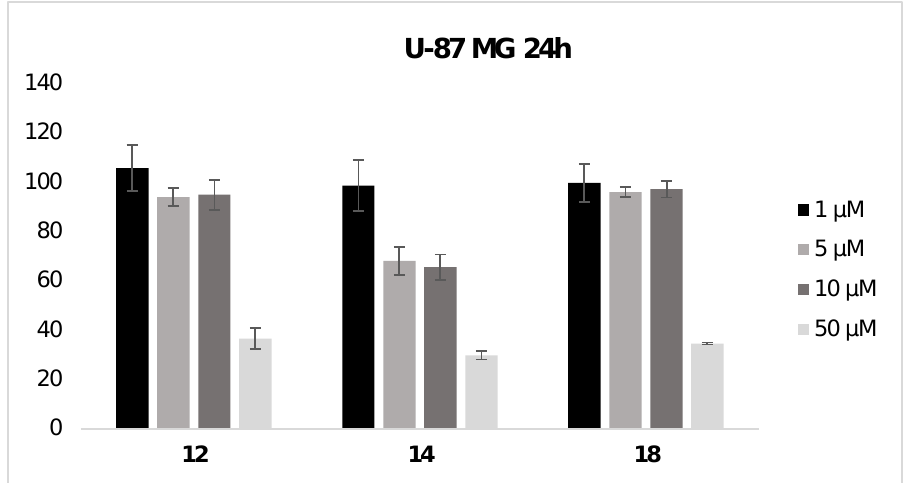
Figure 8. Cell viability assay of U-87 MG cells in the presence of an increasing concentration of the studied compounds was evaluated using the MTT method. Data represent the absorbance relative to untreated cells in the same experiment and standardized to 100%. All data points were performed in triplicate and at least in three independent experiments.